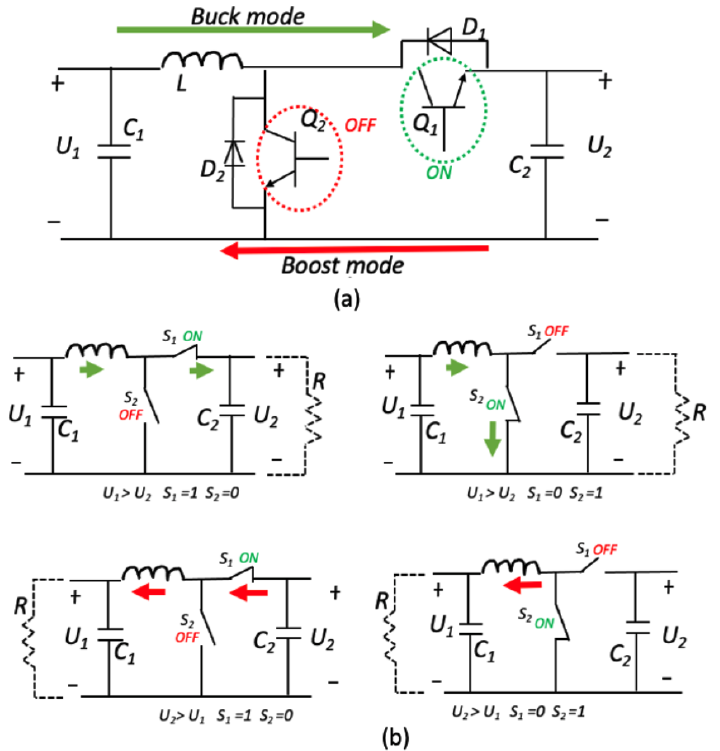
Figure 8. BidirectionalDC–DC converter